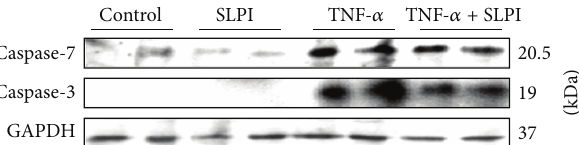
Figure 4: Effect of SLPI on active caspase-3 and caspase-7 pro- tein levels. U937 cells were pretreated with SLPI (10 𝜇 g/mL) and stimulated with TNF- 𝛼 (10ng/mL) for 4 hr. RIPA extracts were electrophoresedon10–15%SDS-PAGEgelsandanalysedbyWestern blotting using anti-caspase-3 and anti-caspase-7 antibodies. The blots were tripped and reprobed for GAPDH to control for protein loading. Results are representative of 𝑛 = 3 .